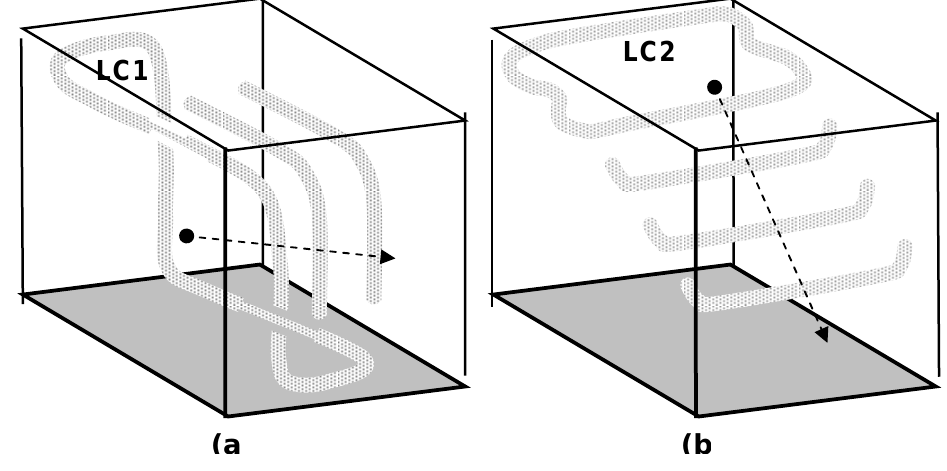
(a (b Figure 5: Positioning e-business systems LCs in the Boisot I-Space